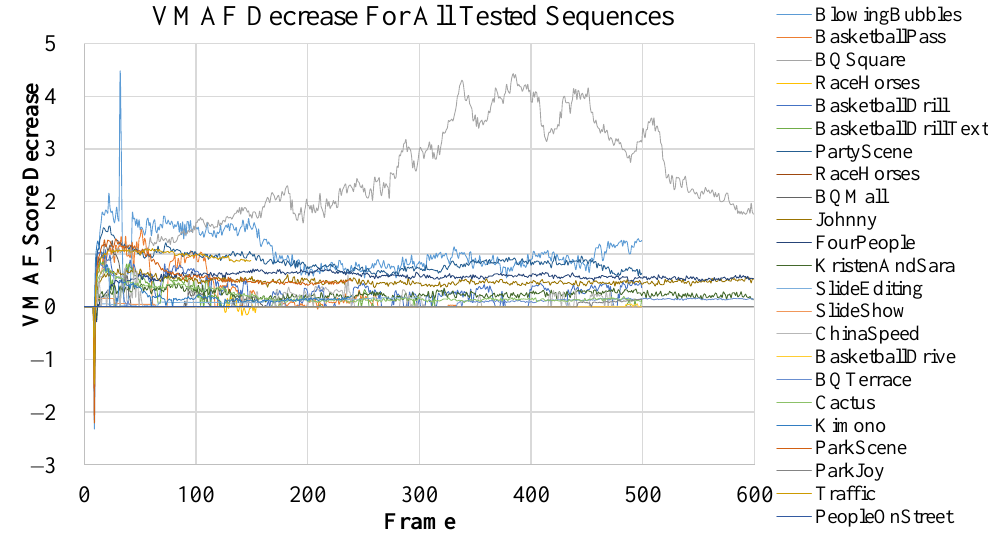
Figure 6. VMAF score decreases of KI src of all tested sequence, encoded with QP NS = QP CS = 22.